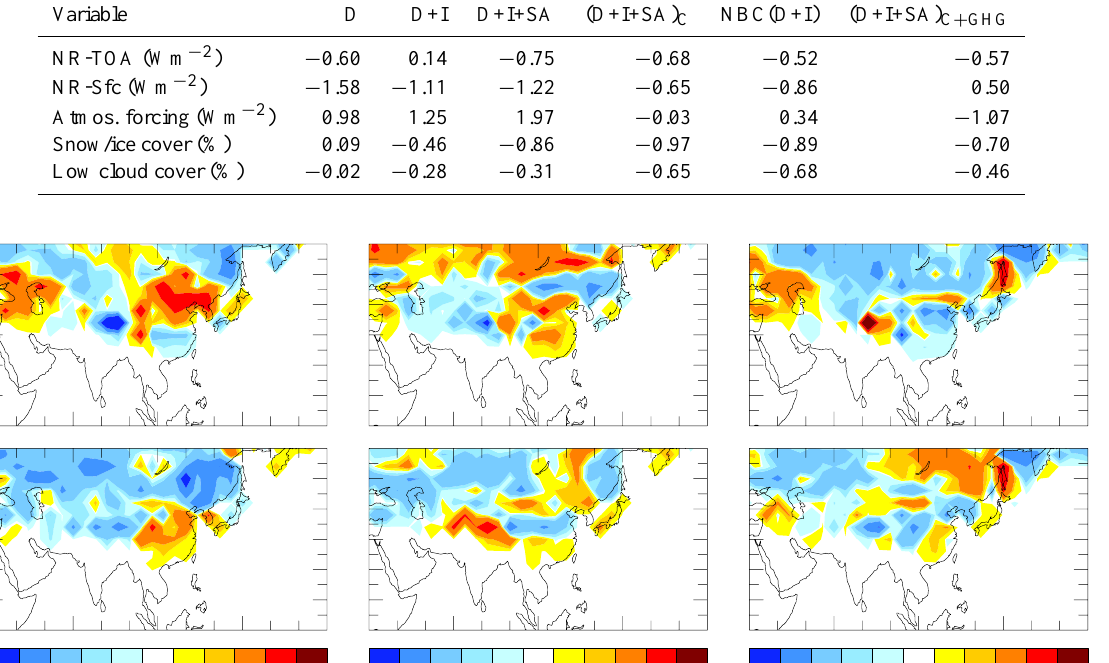
Fig. 3. Difference in annual average snow/ice cover for differences in emissions between 2000 and 1990 due to the direct effect (D) (left panels), direct+indirect effect (D+I) (middle panels) and D+I+snow albedo changes due to black carbon deposition (SA) along with sea- surface temperature (SST) and GHG changes for Year 2000 emissions ((D+I+SA) C + GHG ) (right panels) for the Beig (top panels) and Bond (bottom panels) emissions.